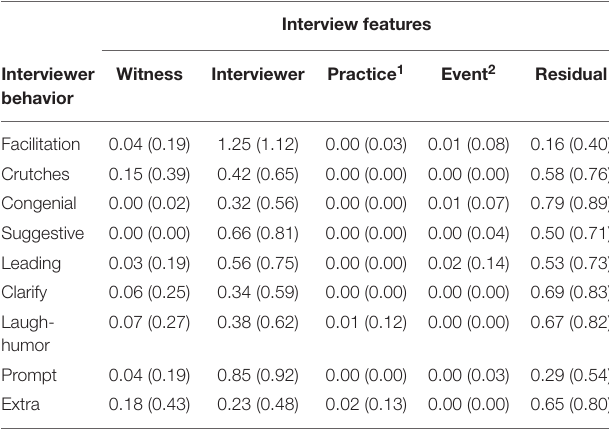
TABLE 6 | The standardized estimates (SD) of witness, interviewer, practice, witnessed event, and residual variance influence on the interview